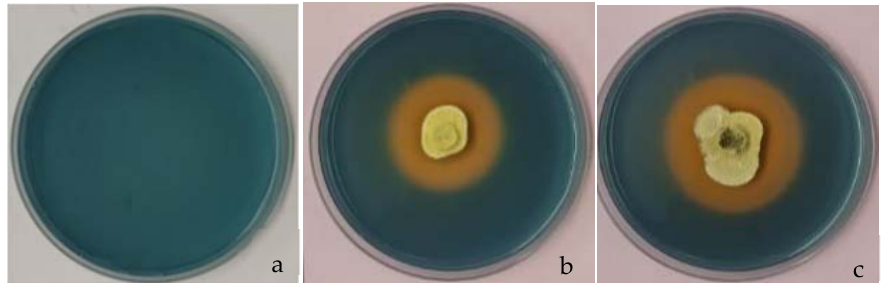
Figure 8. Production of siderophores screened on CAS agar medium (front view) ( a ) uninoculated CAS agar medium, ( b ) CAS medium inoculated with the strain #5001, ( c ) CAS medium inoculated with the strain #5029.